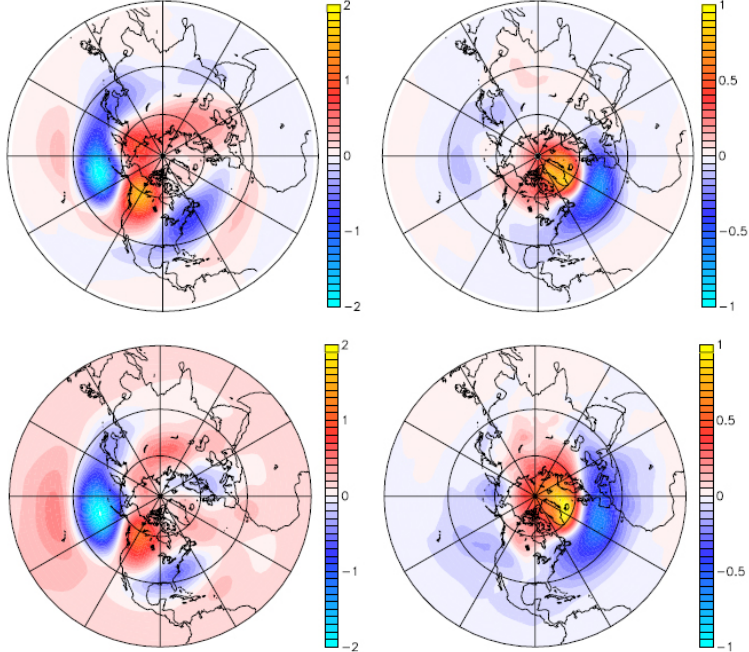
Fig. 13. The regression coefficient of the geopotential height anomalies at 500hPa with the PNA index (left) and the regression of the mean sea-level pressure anomalies with the NAO index (right). The top row shows the results for the SPEEDO model and the bottom row for the NCEP-NCAR Reanalysis (Kalnay et al.,